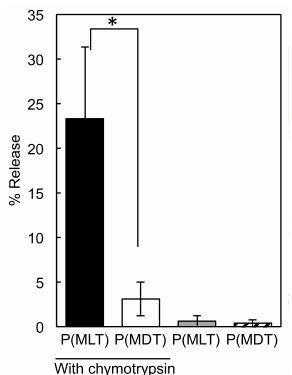
Figure 2. Release of small molecule IDO inhibitors from homopolymers of P(MLT) and P(MDT) with and without chymotrypsin. Data shown as the mean ± S.D. ( n = 3). * p < 0.01 determined by Student’s t -test.